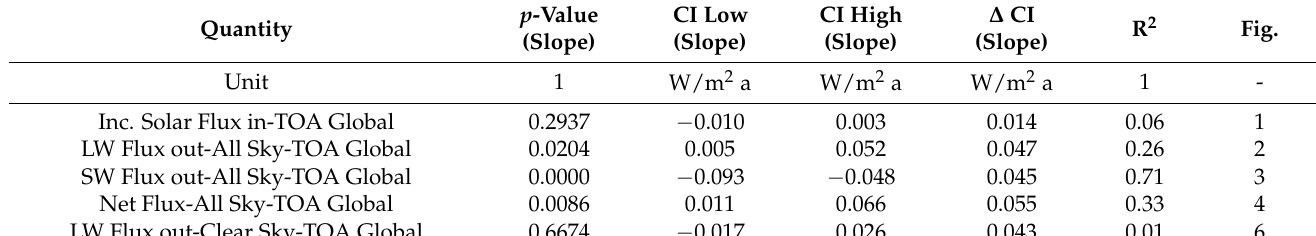
Table A2. Statistical Error Analysis of the TOA Fluxes (part